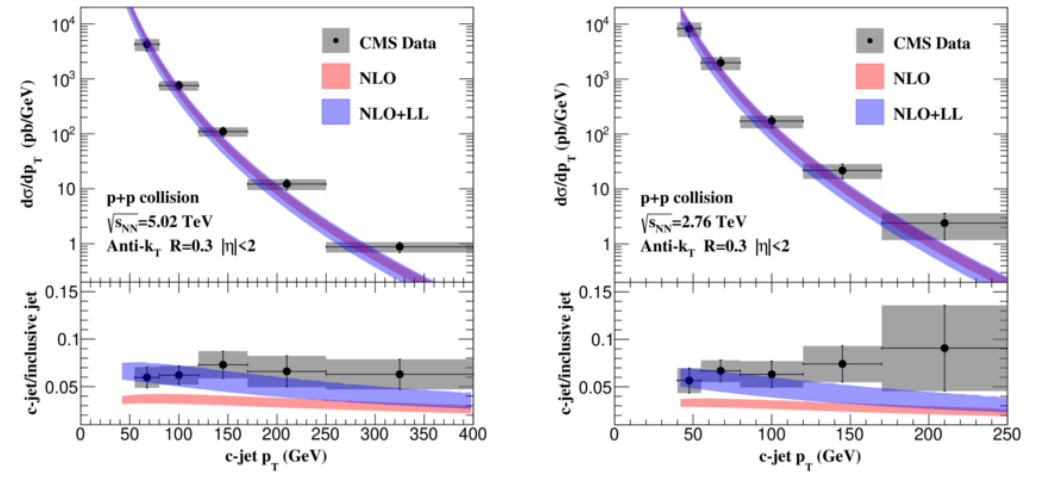
Figure 3 . The c-jet cross sections (top) and their ratios (bottom) to the inclusive jet cross sections in p+p collisions at √ s = 5 . 02 TeV (left) and 2 . 76 TeV (right). The jets as a function of jet p T NN algorithm with R=0.3 and the pseudorapidity cut are reconstructed using the anti-k T imposed. The color scheme is the same as in figure